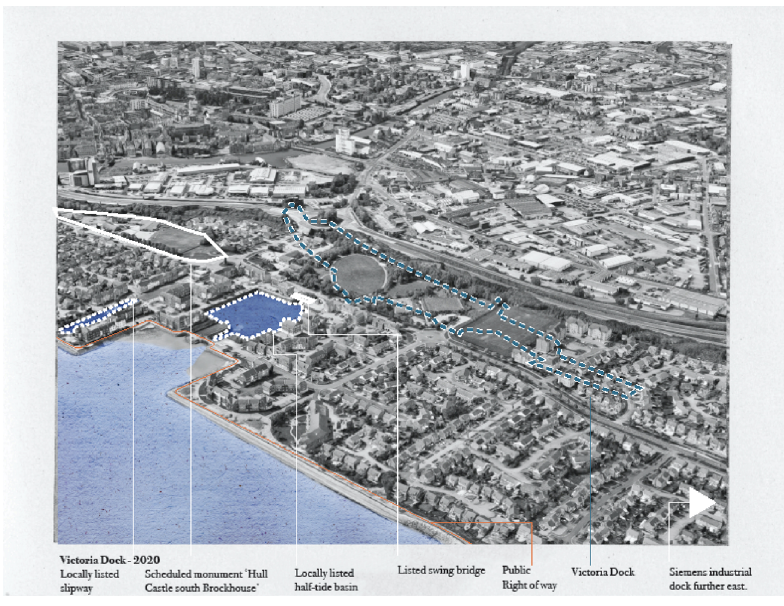
Google Maps satellite photo of Victoria Park. Adapted from ©2020